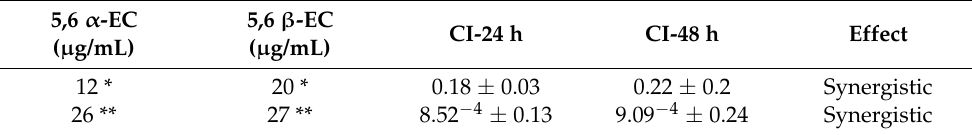
Table 2. Chou–Talalay index for the various combinations of 5,6-ECs.